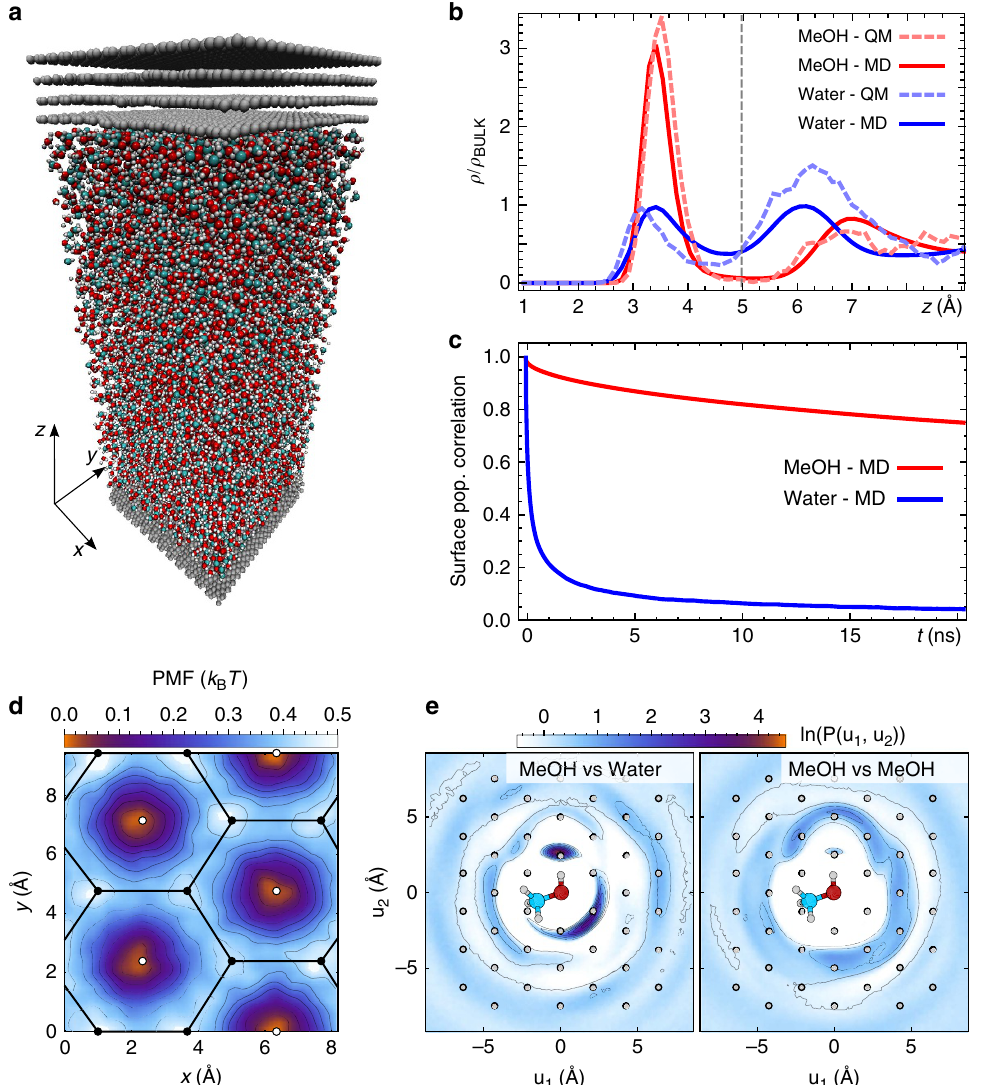
Figure 2 | MD simulations of the water-MeOH mixture at the interface with HOPG. The simulations were performed to explicitly model mixtures of different concentrations on the surface of graphite. ( a ) A snapshot of the (50 (cid:2) 50 (cid:2) 150Å) simulation supercell, using a slab geometry with periodic boundary conditions. ( b ) The density profile along z for a 1:1 water:MeOH mixture shows strongly structured water and MeOH layers between 1 and 5Å. The distributions obtained with an empirical force field are in good agreement with reference ab initio calculations on a smaller supercell (Supplementary Fig. 6). ( c ) The relaxation time for molecules in the first layer above the surface is in the order of several tens of nanoseconds. ( d ) The spatial distribution of MeOH is consistent with a corrugated potential of mean force (PMF) in the xy plane, commensurate to the graphite lattice. This in-plane corrugation is however much weaker than the potential of mean force along z (in b ). ( e ) In-plane oxygen–oxygen distribution function around a reference MeOH molecule for water (left) and MeOH (right). The reference MeOH molecule is centred with its OH bond aligned along the vertical axis. Water shows an increased propensity for being in the first coordination shell while MeOH sits mainly in the second coordination shell. White dots correspond to the underlying graphite lattice. We note a small mismatch between the characteristic length scale of the water-MeOH H-bond network and the periodicity of the HOPG